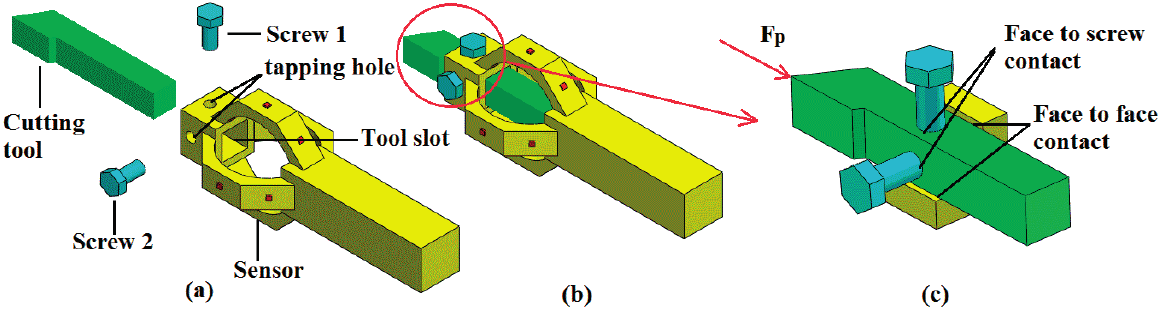
Figure 9. ( a ) Schematic view of the sensor before assemblage; ( b ) Schematic view of the sensor after assemblage; ( c ) Simplified view of the fixing method between the cutting tool and the